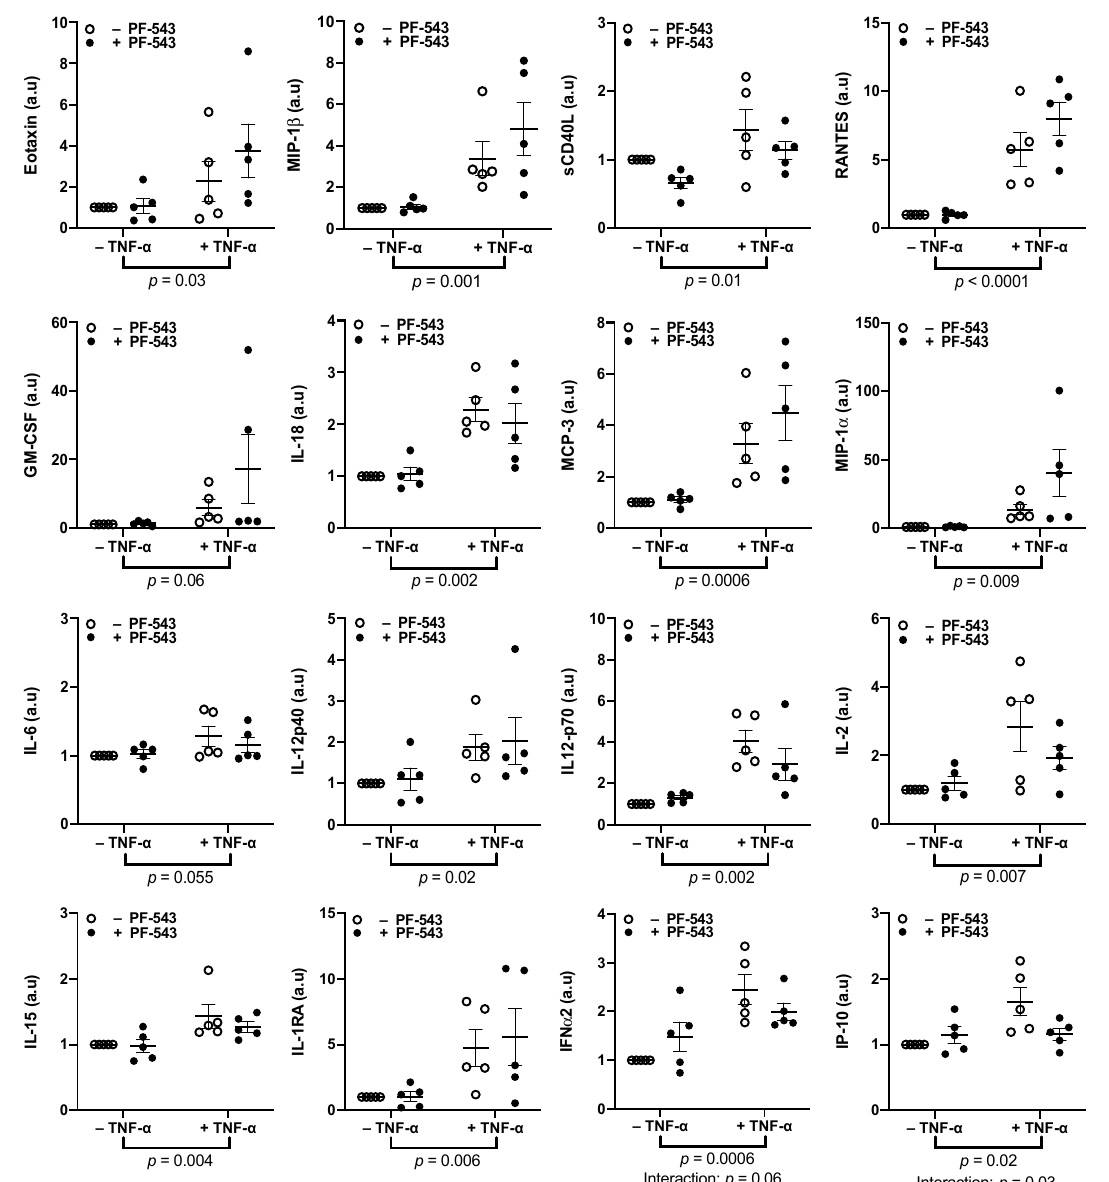
Figure 5. Inhibiting SphK1 with PF-543 diminished TNF- α effects on release of IFN α 2 and IFN- γ associated protein 10 (IP-10). Explants were pre-cultured for 4 days prior to treatment with 10 ng/mL of TNF- α , 1 µ M PF-543, a co-treatment of both, or a no-treatment control for 48 h. Supernatants were centrifuged at 15,000 RPM for 15 min prior to quantification of pro-inflammatory cytokines and chemokines using a multiplex array. Results were normalized against total protein mass, and normalized values were graphed as a ratio of change from the untreated control explant cultures. Results were analyzed by two-way ANOVA with the two-stage linear step-up procedure of Benjamini, Krieger, and Yekutieli post-hoc test. ( n = 5, Mean ± SEM). TNF- α also increased the release of the following growth factors (Figure 6, n = 5): fractalkine ( p = 0.009), IL-7 ( p = 0.01), EGF ( p < 0.0001), and Flt3L ( p < 0.0001). Two inter- leukins that are decreased in PE, IL-4 ( p = 0.002) and IL-9 ( p = 0.02), were also increased by this treatment. The increased release of these factors was independent of SphK1 activation. TNF- α increased the release of FGF2 ( p = 0.02) and PDGF-AA ( p = 0.01) (Figure 6) which was dependent on SphK1 since co-treatment of TNF- α with PF-543 decreased this release ( p = 0.02 and p = 0.01, respectively) with treatment interactions of p = 0.06 and p =